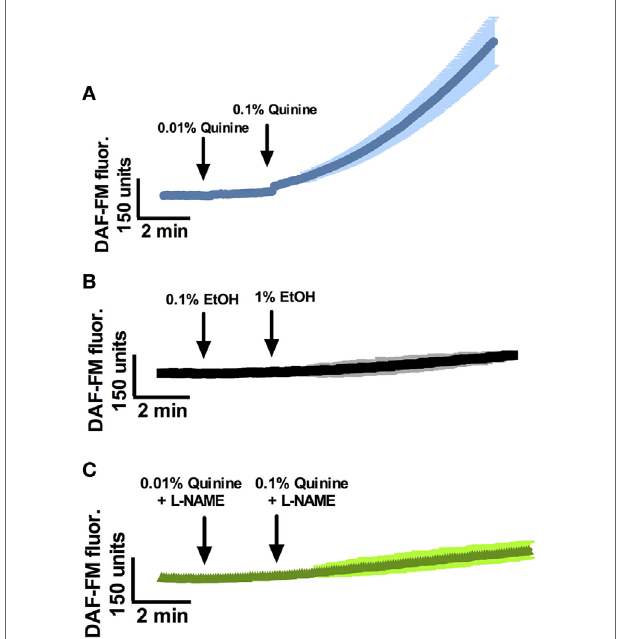
FigUre 1 | Quinine stimulates nitric oxide (NO) responses in a dose- dependent manner in sinonasal air–liquid interfaces. (a) NO responses to 0.01% and 0.1% quinine, (B) EtOH vehicle, and (c) quinine in the presence of l -N G -nitroarginine methyl ester (L-NAME) ( n = 3–6 cultures). NO response to quinine is significantly greater than response to EtOH vehicle or quinine plus L-NAME after a period of 10 min, p <